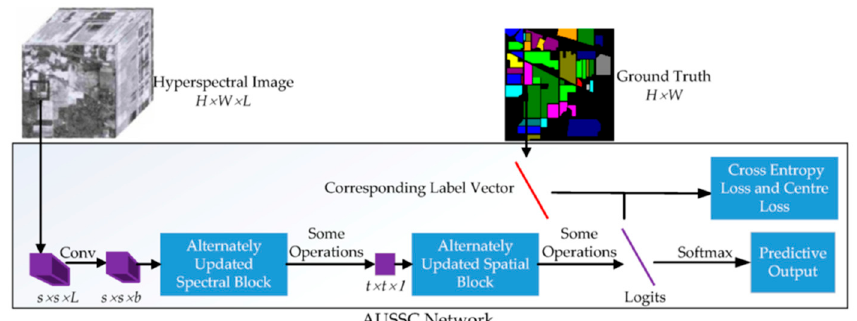
Figure 1. An overview of the proposed end-to-end alternately updated spectral–spatial convolutional network (AUSSC). “Conv” refers to the convolution operation. The operations denoted by “Some operations” are presented in detail in Section 2.4. “Logits” refers to the output of the last fully connected layer. Classification results are acquired after the Softmax operation.